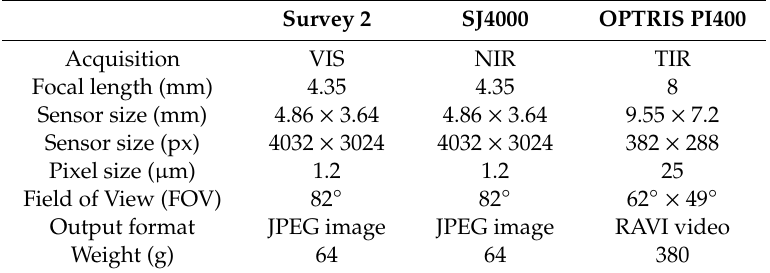
Table 1. Technical specifications of the three cameras used for the vegetation survey.